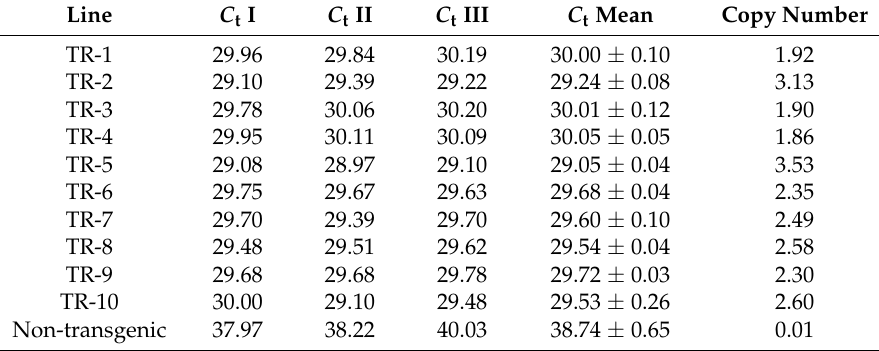
Table 1. Estimated cry2A gene copy number of different transgenic lines.